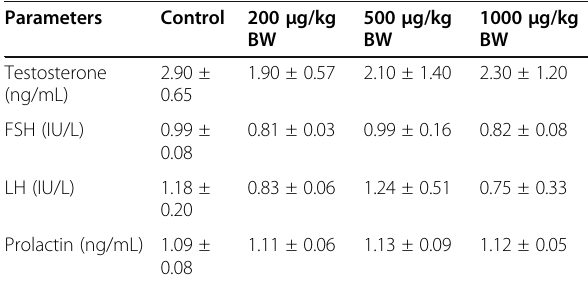
Table 7 Effect of chromatographic fractions of Waltheria indica Linn . root on sperm parameters of male Wistar rats (Mean ± SD, n = 5 for each